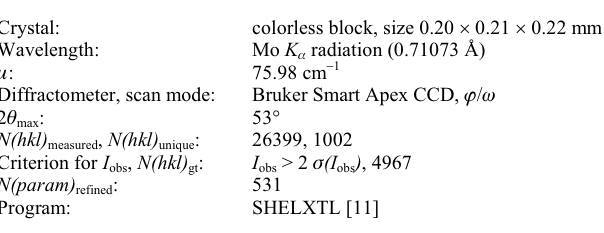
Table 1. Data collection and handling.